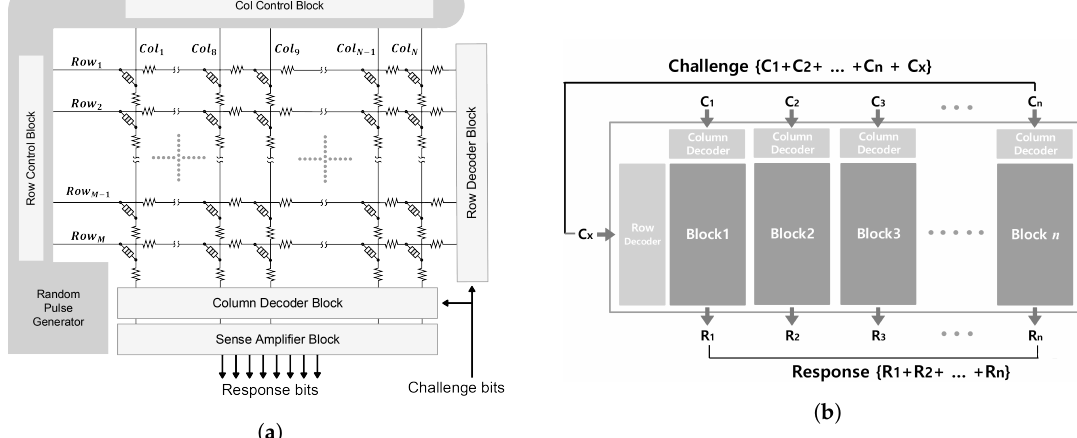
Figure 6. Simplified pulsewidth-based memristive PUF (pm-PUF) architecture [29]. ( a ) Simplified pulsewidth-based memristive PUF (pm-PUF) architecture. ( b ) A concept of bank design for